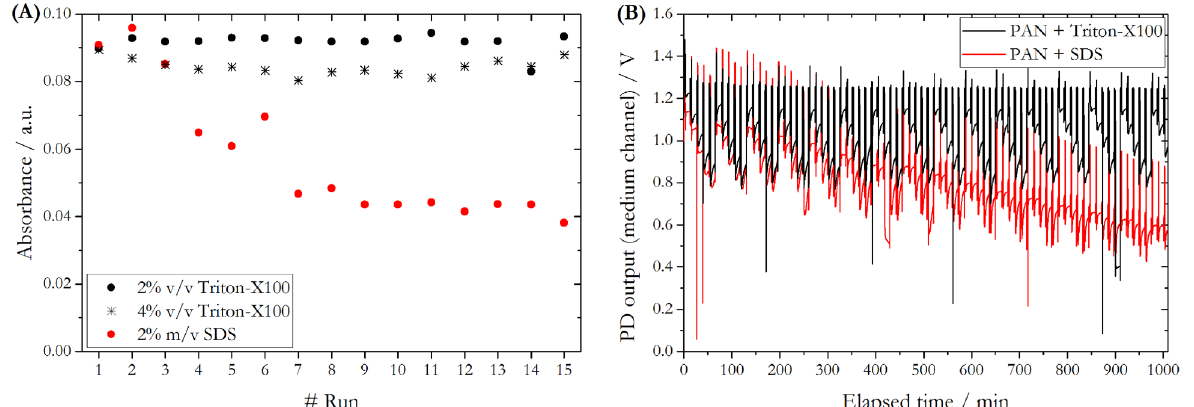
Figure 2. ( A ) Processed absorbance values of the analyser’s medium channel of a 500 nM Mn standard solution analysed using three differently prepared 0.8 mM PAN reagents. ( B ) PD raw output from medium channel of LoC analyser for 15 consecutive runs of a calibration using four different Mn(II) standard solutions and 0.8 mM PAN reagent prepared with 2% v/v Triton-X100 and 2% m/v SDS.